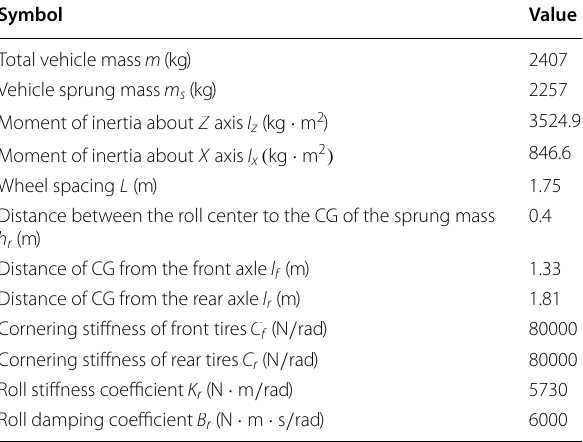
Table 1 Vehicle parameters of autonomous vehicles